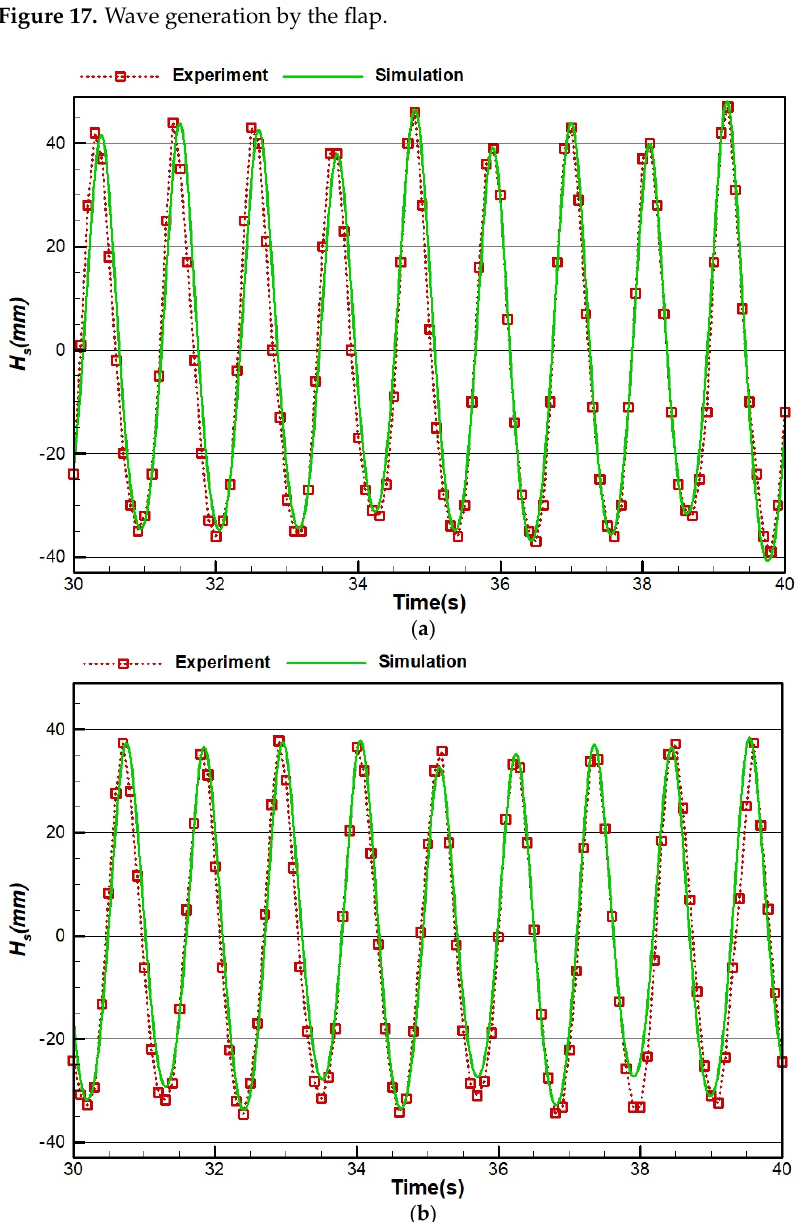
Figure 18. Wave height of case 1 at distances of ( a ) 3 m and ( b ) 5 m from the flap.